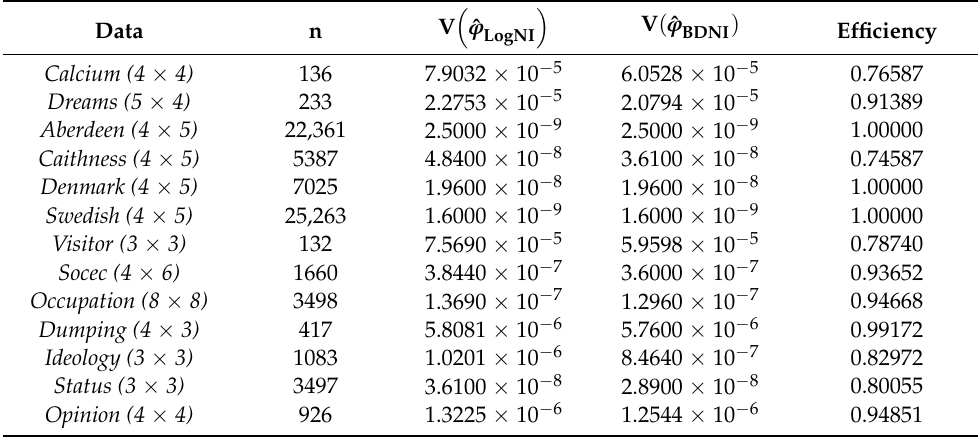
Table 5. Standard errors and efficiency of ˆ ϕ BDNI and ˆ ϕ LogNI for 13